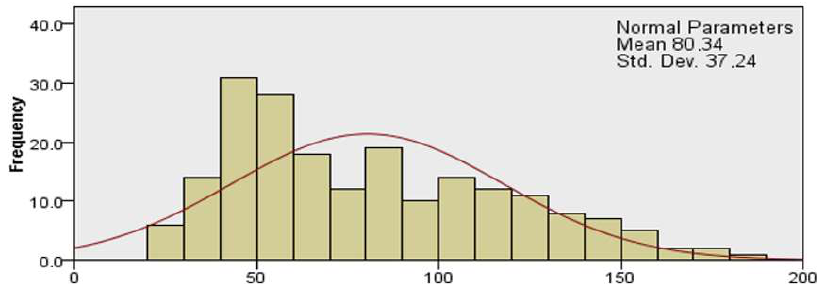
Figure 1. Total burnout score for healthcare professionals.